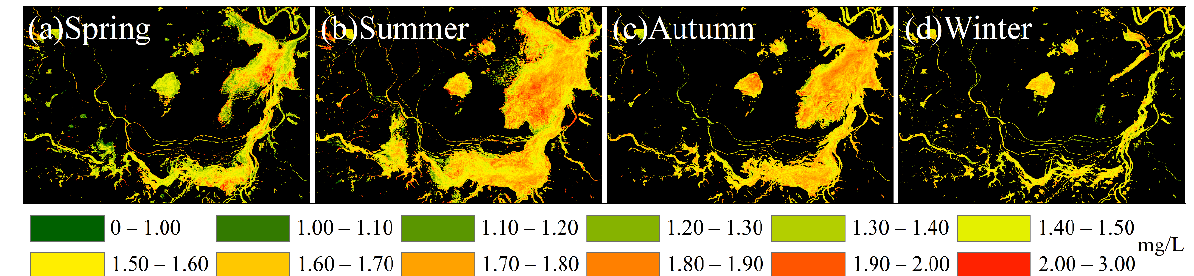
Figure 7. Quarterly composite image of TP content in Dongting Lake.